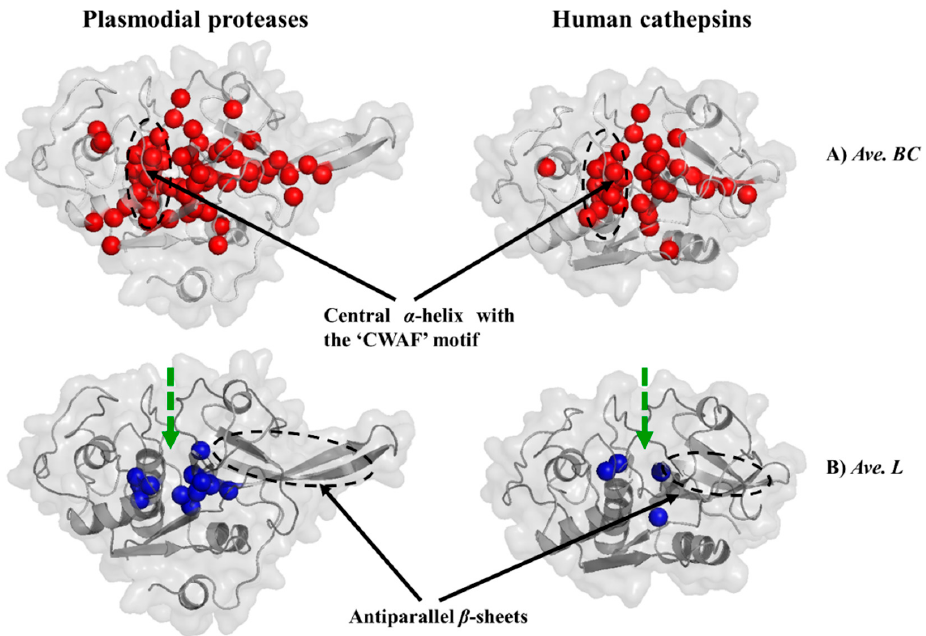
Figure 8. Key communication hubs in plasmodial proteases and their human homologs. Structural mapping of residues with significantly high average BC ( A , red) and low average L ( B , blue) values in plasmodial proteases and human cathepsins in both ligand-bound and ligand-free states. Active site location is shown by the thick green broken line.